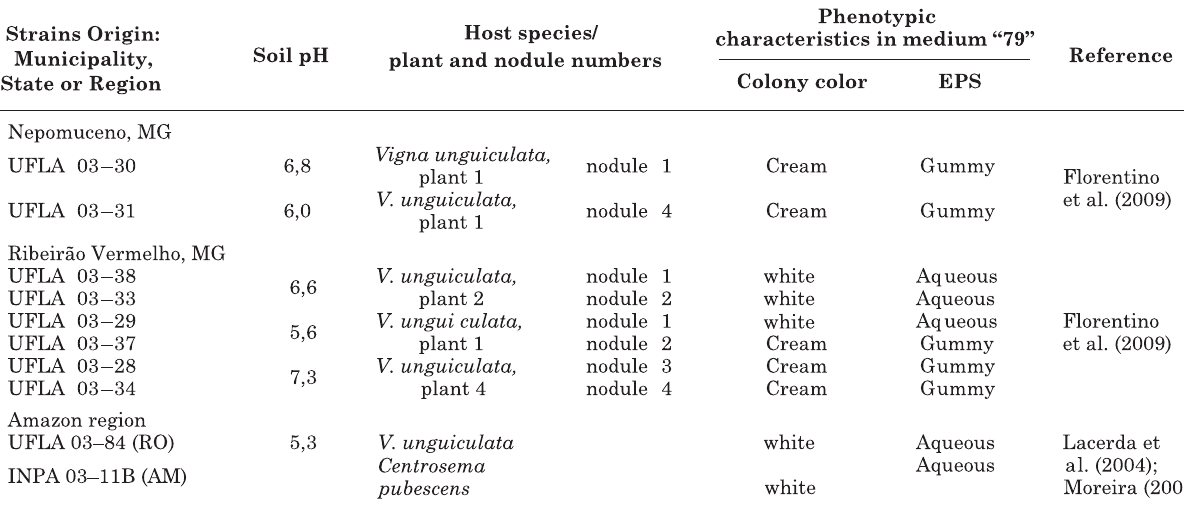
Table 1. pH values of the soil of origin, indication of cowpea plants and nodules from which the Bradyrhizobium strains were isolated, and phenotypic characteristics in medium